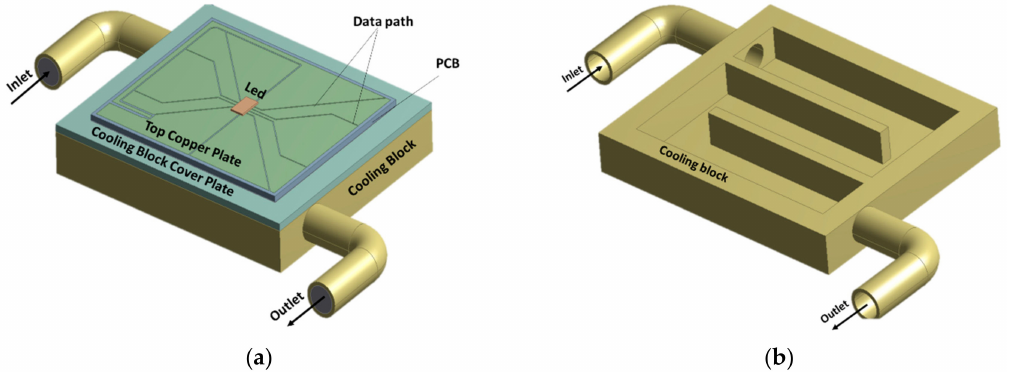
Figure 1. ( a ) Assembly of the LED PCB with liquid cooling block; ( b ) mini-channel structure of the cooling block.